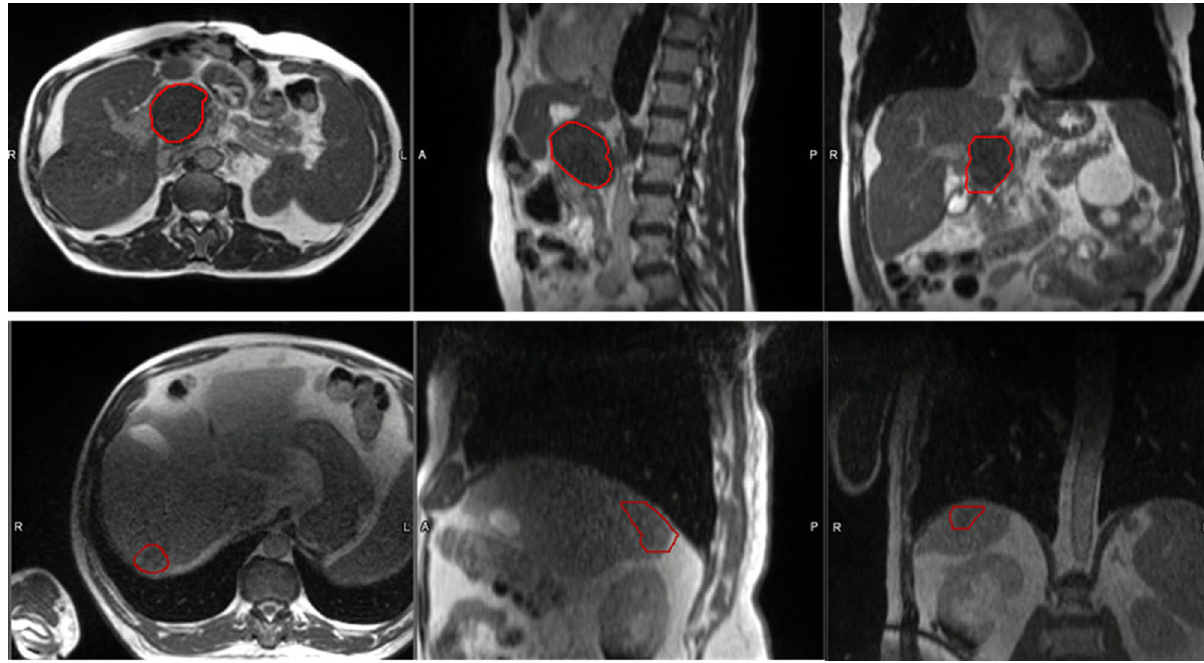
Figure 1. Target volume delineation example. The image displays two patient GTVs contoured on the fraction 1 set up scan. Each row is a different patient with the GTV contoured in red. From left to right, axial, sagittal, and coronal views are displayed,